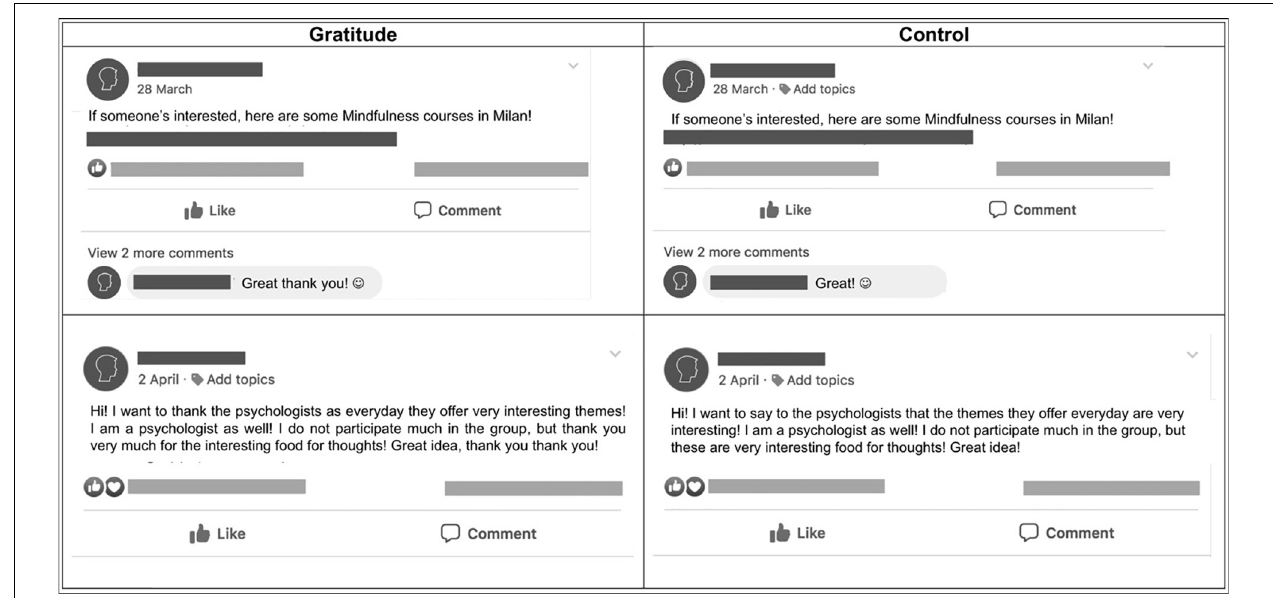
FIGURE 1 | Some examples of Facebook posts used by accomplices to implement the manipulation of gratitude exposure: an action-and-response chat posted in the gratitude group (top left) ; the same action-and-response chat posted in the control group (top right) ; a single public post, addressed to all group’s members posted in the gratitude group (bottom left) ; and the same single public post, posted in the control group (bottom right) . Posts’ original content was in Italian; the same content is here translated from Italian into English for example purposes.